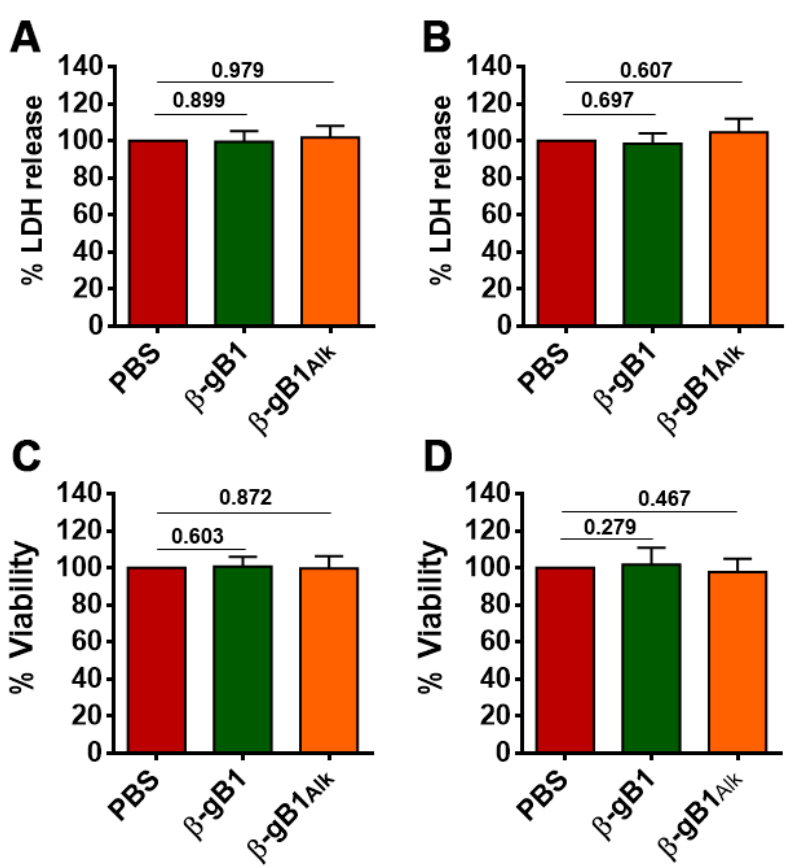
Figure 4. Effect of β -ginkgotide in cell growth and death . The cytotoxicity and plasma membrane-damaging effect was measured by a lactate dehydrogenase (LDH) release assay. Cells were cultured and with or without 10µM of β -gB1/ S -alkylated β -gB1 ( β -gB1 Alk ) for 48 h, and an LDH release was measured by an LDH assay kit. PBS was used as a vehicle control. The Y-axis represents the % LDH release by H9c2 ( A ) and SH-SY5Y ( B ) cells compared to their vehicle control counterpart. Statistical significance was determined from experimental triplicates. Cells were cultured with or without 10µM of β -gB1 and S -alkylated β -gB1 ( β -gB1 Alk ) for 48 h, and viability was measured by an MTT assay. The relative viability of H9c2 ( C ) and SH-SY5Y ( D ) cells are expressed as mean values, and statistical significance was calculated from independent experimental triplicates.